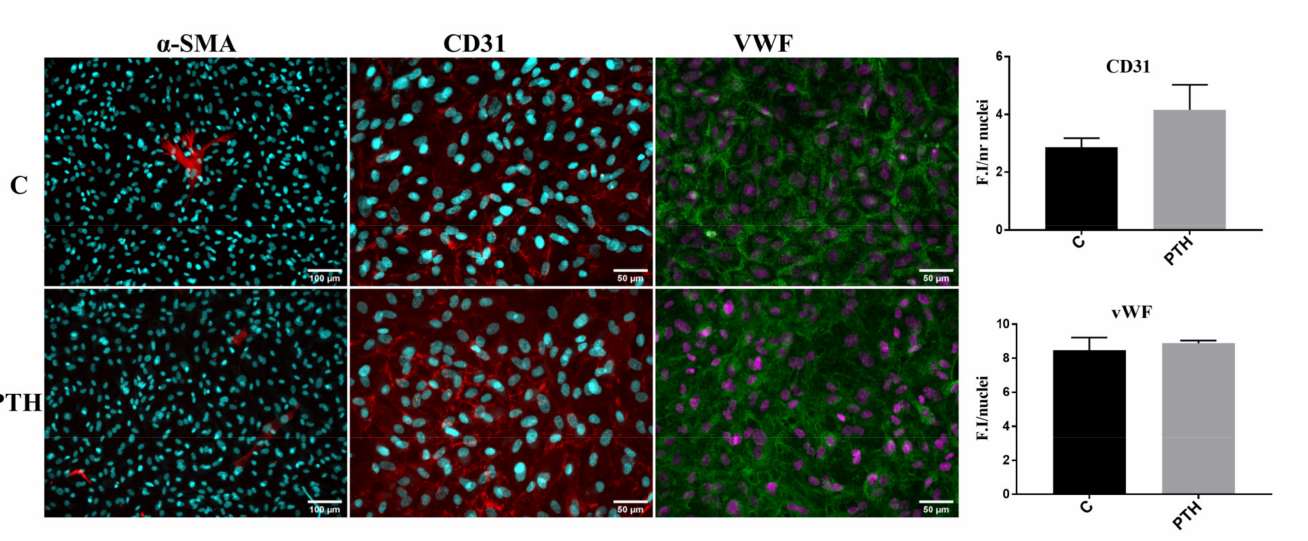
Figure 4. Expression of markers associated with EndMT transition of endothelial cells. Immunoflu- orescence staining of mesenchymal marker— α SMA (red) and of endothelial markers—CD31 (red) and vWF (green) in valvular endothelial cells control (C) or after 7 days of PTH exposure (PTH). Mean fluorescence intensity (FI) of images was calculated for the fluorophore and normalized to the number of cell nuclei stained with DAPI (cyan or purple